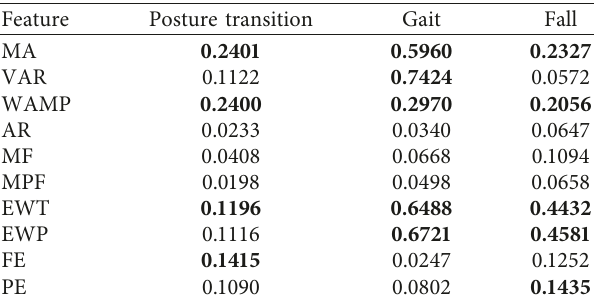
Figure 5: Placement of FSR402 pressure sensors. Table 2: Class separability indexes of 10 features for posture transition, gait, and fall.